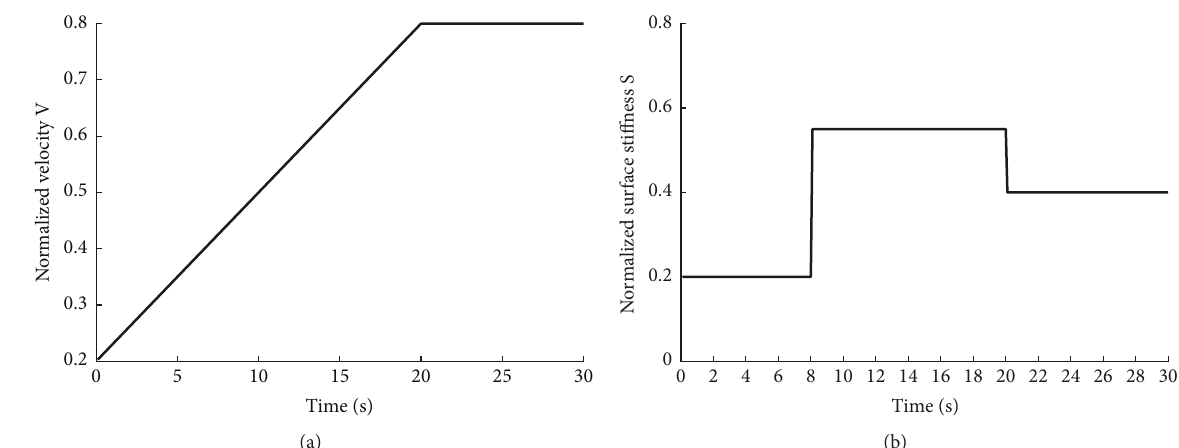
Figure 15: Normalized velocity surface stiffness used in the simulation.